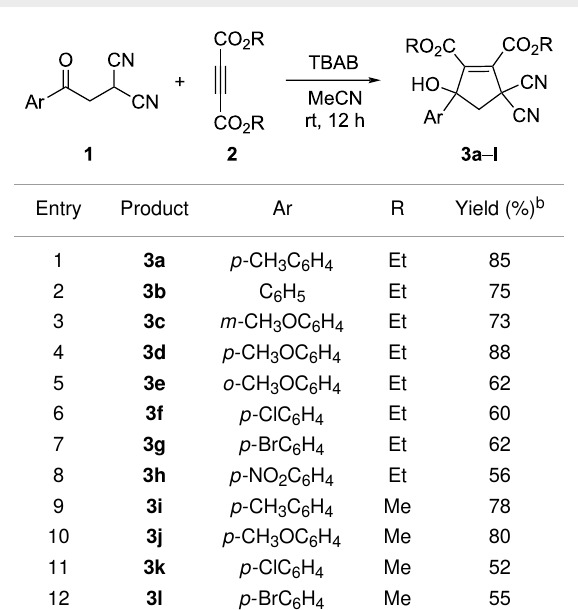
Table 2: Synthesis of functionalized cyclopentenes 3a – l . a